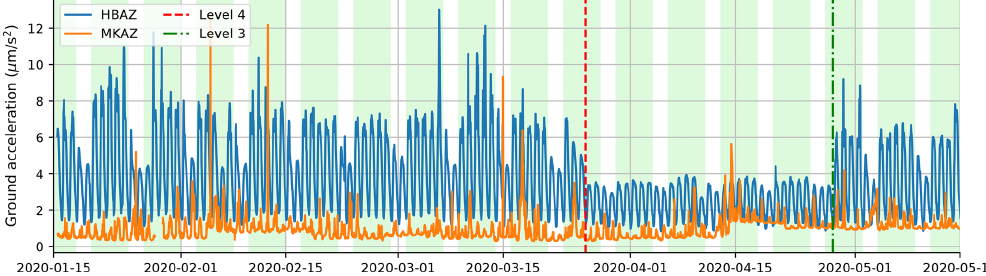
Figure 4. RSAM at short-period borehole seismometer HBAZ and the nearest broadband station (MKAZ). In addition to the contrasts in RSAM values for days, nights, weekends and weekdays, the Level-4 lockdown period (its start marked by a dashed red line and the transition to Level 3 is annotated by a dash-dotted green line) is marked by lower RSAM values for station HBAZ.